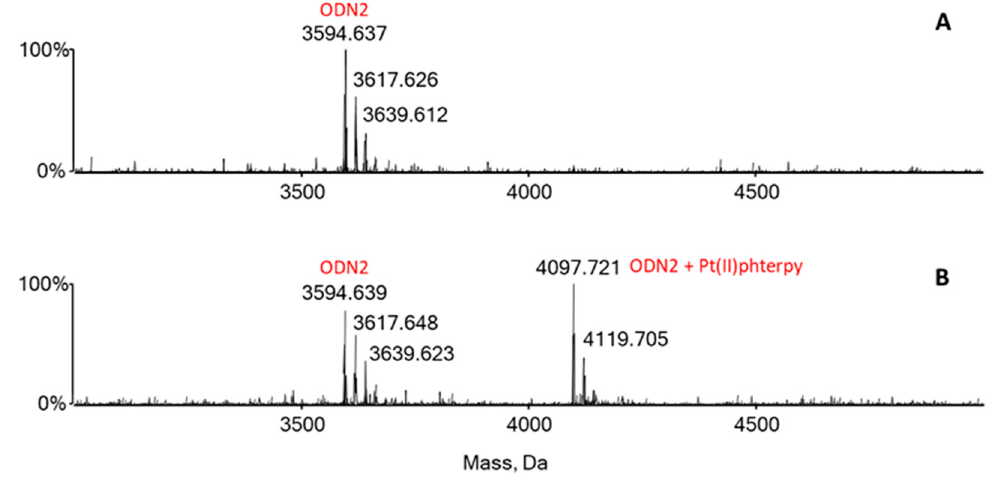
Figure 5. Deconvoluted ESI mass spectra of ODN2 (10 − 4 M) incubated at room temperature for 24 h with 1 (1:1 metal to ODN ratio) in LC-MS water (with 4% DMSO and 3% acetone). Panel ( A )—complex 1 in the dark; panel ( B )—complex 1 irradiated for 5 min at 365 nm (UV lamp).